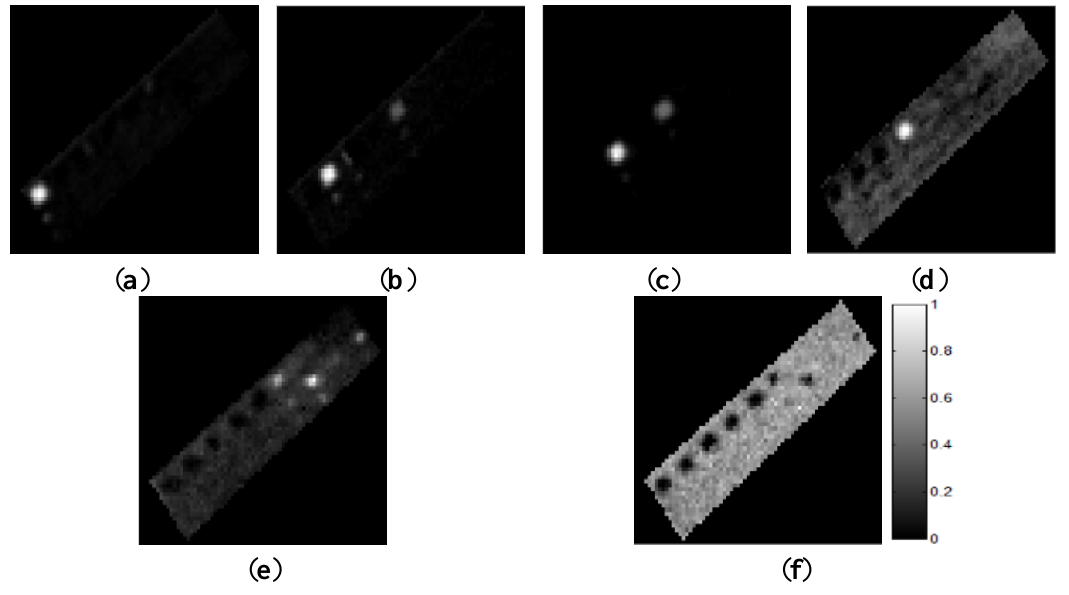
Figure 9. Abundance maps of the final endmembers in the AISA dataset obtained using the proposed method. ( a ) 𝐸